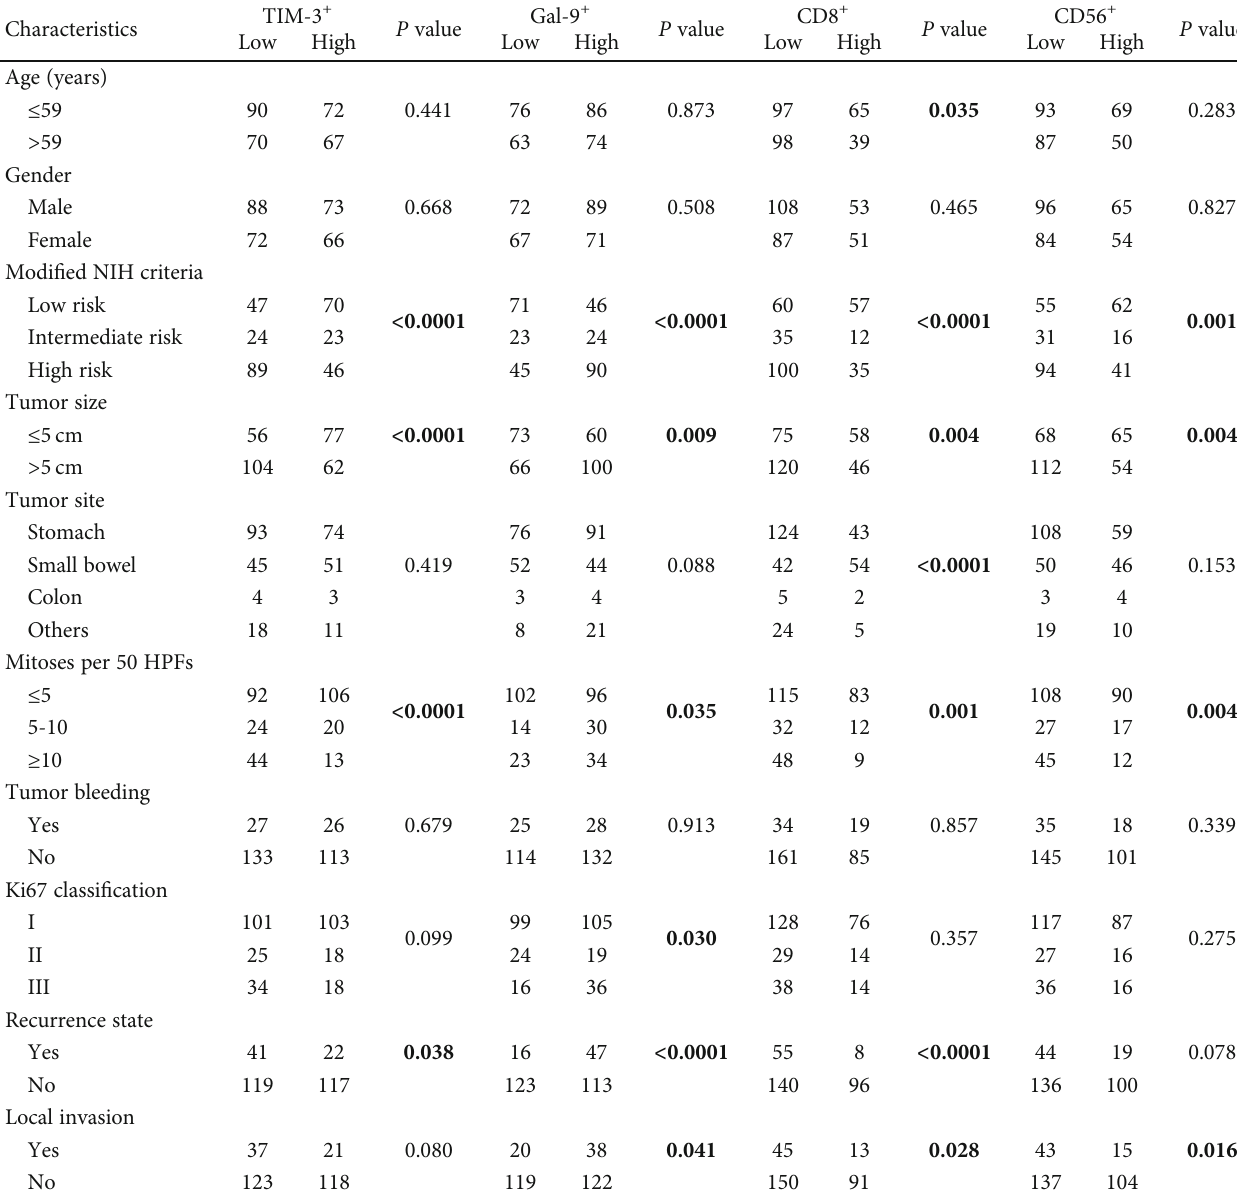
Table 2: Correlation of TIM-3 + , Gal-9 + , CD8 + , and CD56 + TIL densities with clinicopathological characteristics.